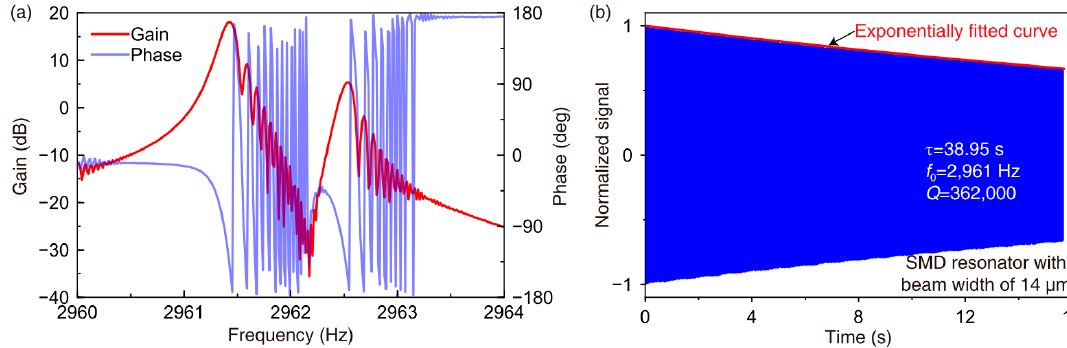
Figure 5. ( a ) Typical frequency response and ( b ) ring-down signal of the n = 2 wineglass mode of a SMD disk resonator with beam width of 14 μ m.